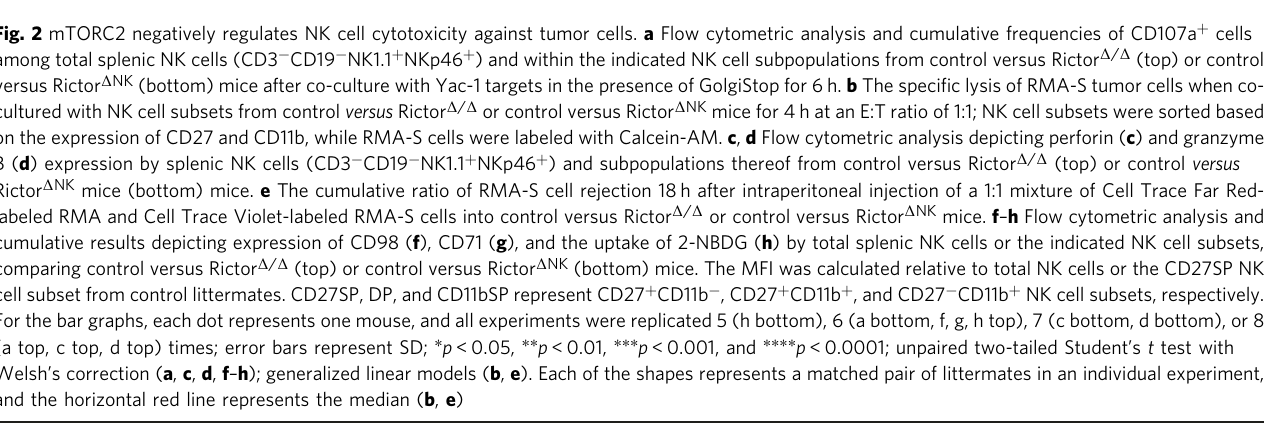
Fig. 2 mTORC2 negatively regulates NK cell cytotoxicity against tumor cells. a Flow cytometric analysis and cumulative frequencies of CD107a + cells among total splenic NK cells (CD3 − CD19 − NK1.1 + NKp46 + ) and within the indicated NK cell subpopulations from control versus Rictor Δ / Δ (top) or control versus Rictor Δ NK (bottom) mice after co-culture with Yac-1 targets in the presence of GolgiStop for 6 h. b The speci fi c lysis of RMA-S tumor cells when co- cultured with NK cell subsets from control versus Rictor Δ / Δ or control versus Rictor Δ NK mice for 4 h at an E:T ratio of 1:1; NK cell subsets were sorted based on the expression of CD27 and CD11b, while RMA-S cells were labeled with Calcein-AM. c , d Flow cytometric analysis depicting perforin ( c ) and granzyme B ( d ) expression by splenic NK cells (CD3 − CD19 − NK1.1 + NKp46 + ) and subpopulations thereof from control versus Rictor Δ / Δ (top) or control versus Rictor Δ NK mice (bottom) mice. e The cumulative ratio of RMA-S cell rejection 18 h after intraperitoneal injection of a 1:1 mixture of Cell Trace Far Red- labeled RMA and Cell Trace Violet-labeled RMA-S cells into control versus Rictor Δ / Δ or control versus Rictor Δ NK mice. f – h Flow cytometric analysis and cumulative results depicting expression of CD98 ( f ), CD71 ( g ), and the uptake of 2-NBDG ( h ) by total splenic NK cells or the indicated NK cell subsets, comparing control versus Rictor Δ / Δ (top) or control versus Rictor Δ NK (bottom) mice. The MFI was calculated relative to total NK cells or the CD27SP NK cell subset from control littermates. CD27SP, DP, and CD11bSP represent CD27 + CD11b − , CD27 + CD11b + , and CD27 − CD11b + NK cell subsets, respectively. For the bar graphs, each dot represents one mouse, and all experiments were replicated 5 (h bottom), 6 (a bottom, f, g, h top), 7 (c bottom, d bottom), or 8 (a top, c top, d top) times; error bars represent SD; ∗ p < 0.05, ∗∗ p < 0.01, ∗∗∗ p < 0.001, and ∗∗∗∗ p < 0.0001; unpaired two-tailed Student ’ s t test with Welsh ’ s correction ( a , c , d , f – h ); generalized linear models ( b , e ). Each of the shapes represents a matched pair of littermates in an individual experiment, and the horizontal red line represents the median ( b ,